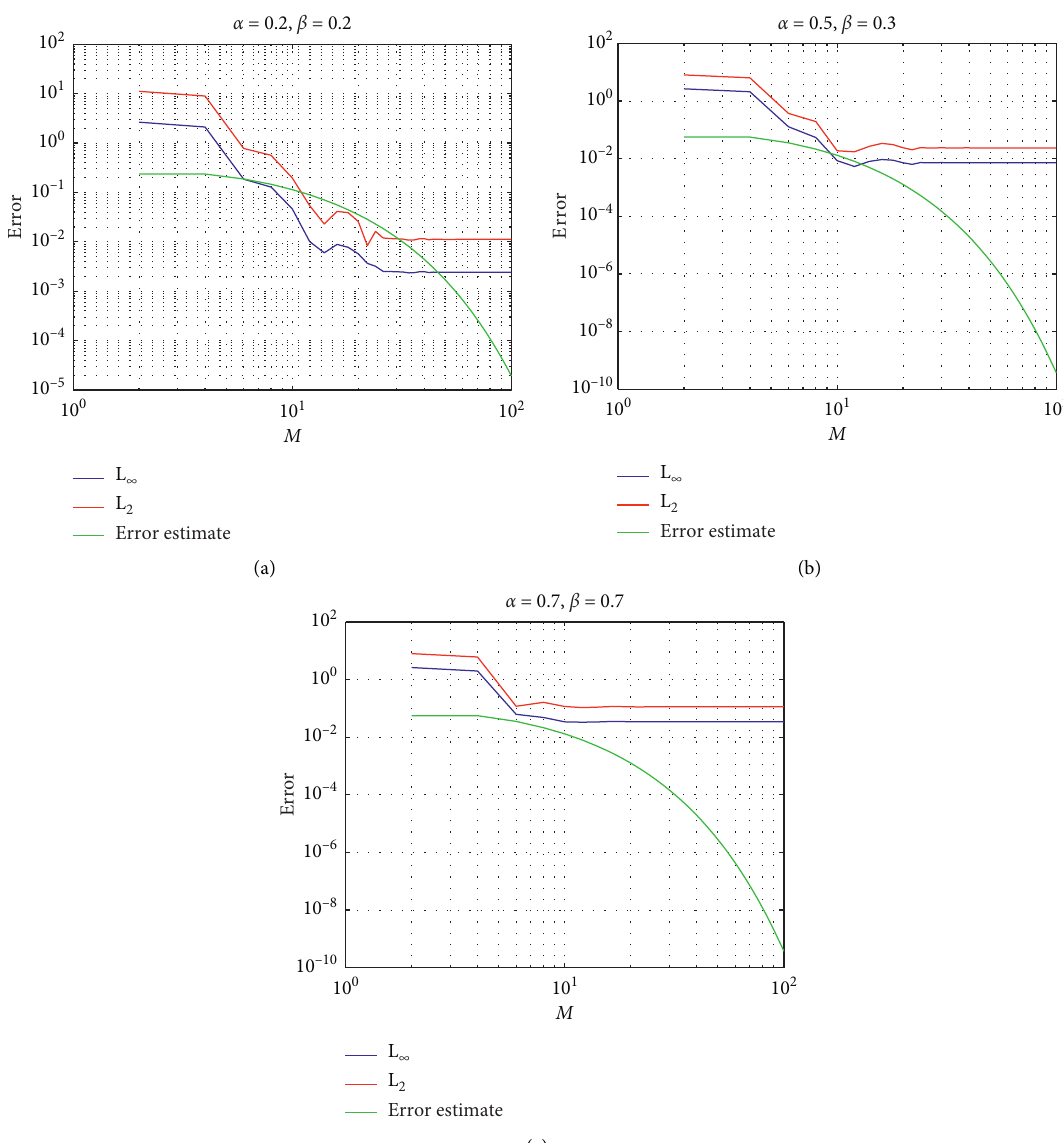
Figure 1: Error versus quadrature points M at t � 1 and various values of α , β corresponding to Problem